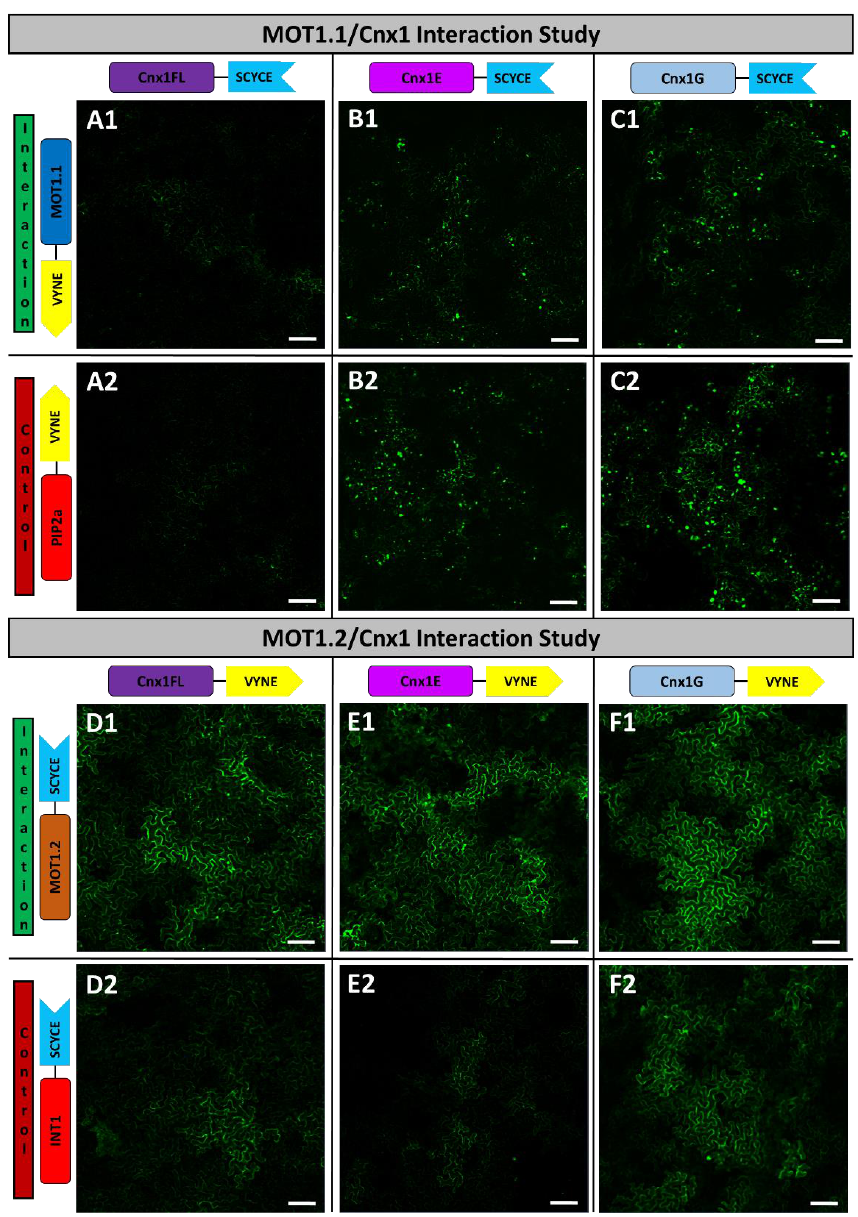
Figure 4. Interaction studies of MOT1 family members and Cnx1 via BiFC. Interaction approaches showing transiently transformed leaves of N. benthamiana co-expressing VYNE-MOT1.1 and Cnx1-SCYCE ( A1 ): Cnx1 full-length (FL)-SCYCE, ( B1 ): Cnx1 E-domain (Cnx1E)-SCYCE, ( C1 ): Cnx1 G-domain (Cnx1G)-SCYCE). In the negative controls ( A2 , B2 , C2 ), PIP2a-VYNE replaces VYNE-MOT1.1. Analogous interaction approaches with MOT1.2-SCYCE and Cnx1FL-VYNE ( D1 ), Cnx1E-VYNE ( E1 ) and Cnx1G-VYNE ( F1 ) are shown. In the negative controls ( D2 , E2 , F2 ), INT-SCYCE replaces MOT1.2-SCYCE. Images were taken with a Plan-Neofluar 10 × /0.3 and scale bars depict a length of 100 µ m. Corresponding abundance controls where NSP3 replaces Cnx1, are shown in Figure